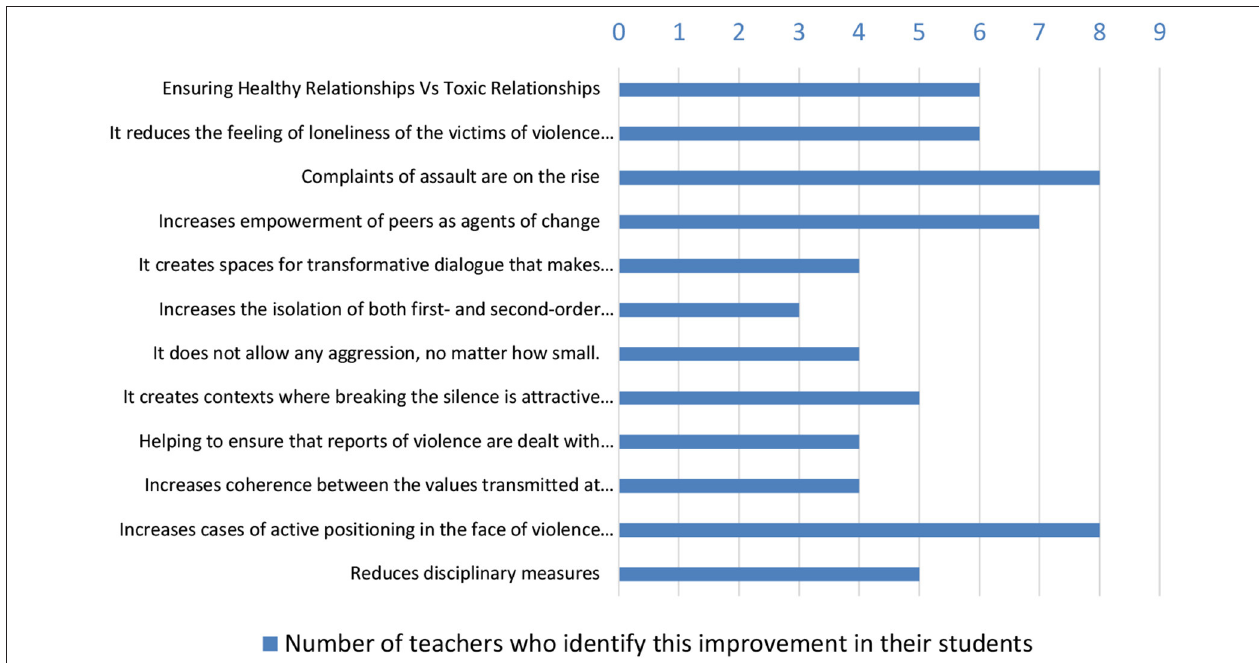
FIGURE 2 | Impact of the Zero Violence Brave Club identified by